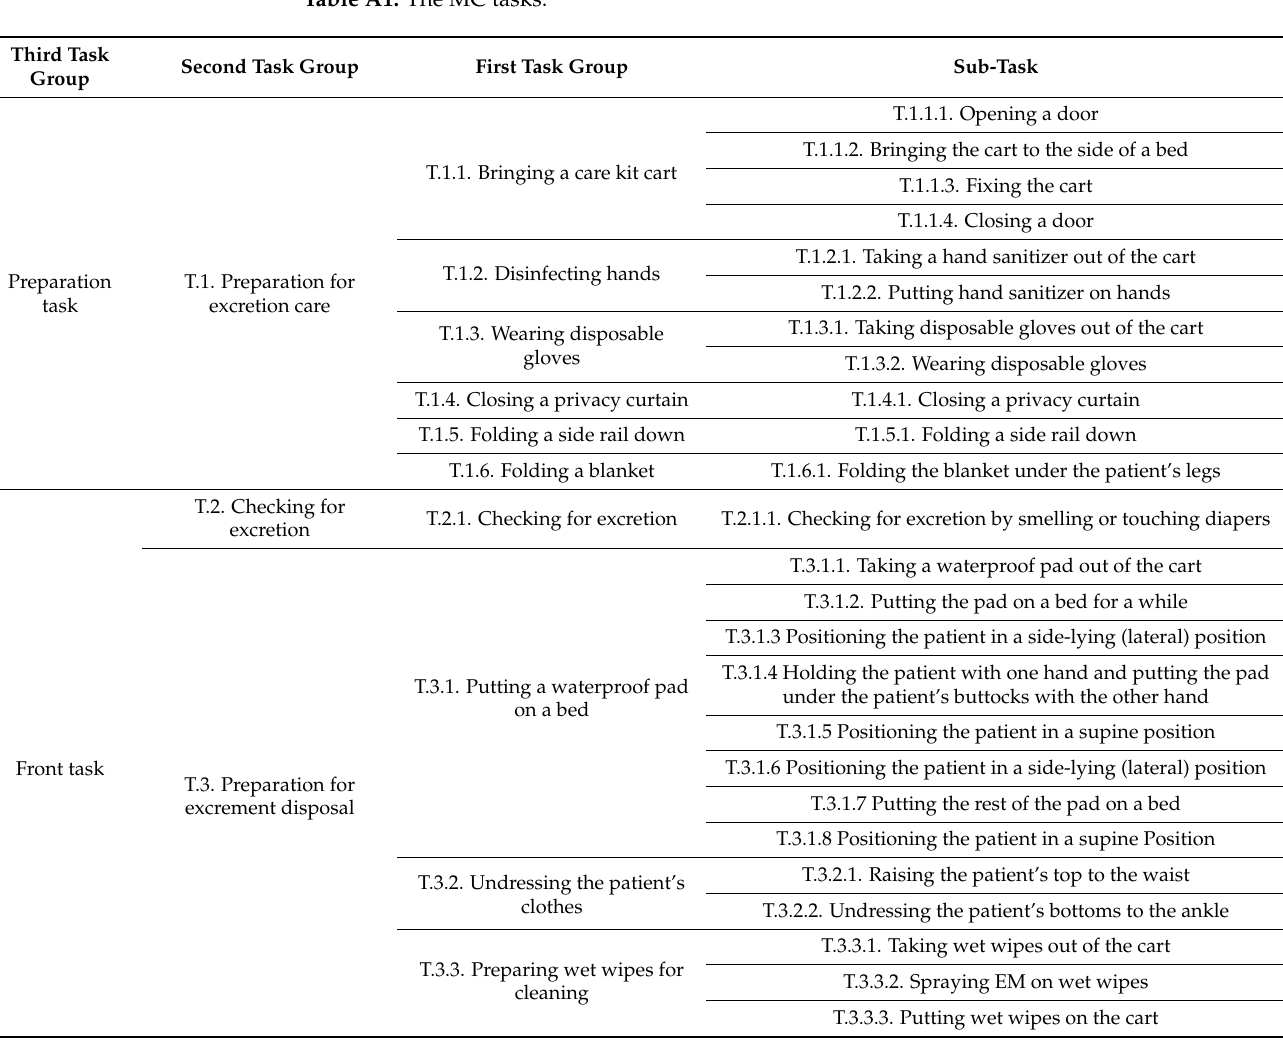
Table A1. The MC